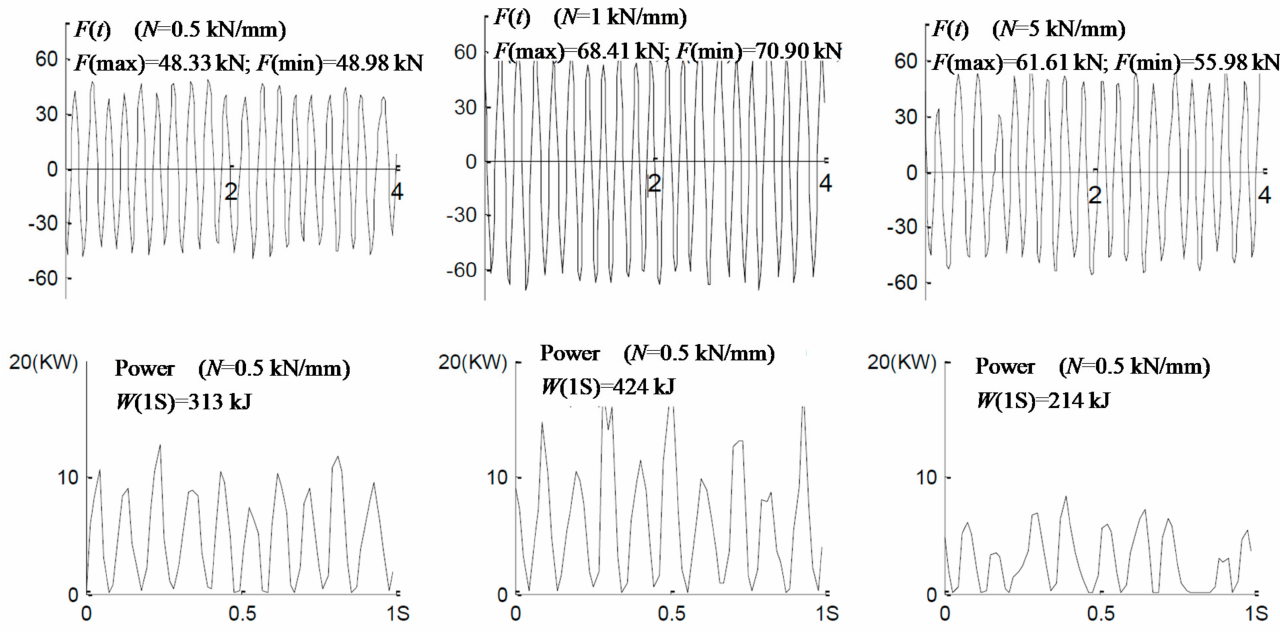
Figure 17. The time − domain diagrams of equivalent excitation force and its work power to the spring component under different elastic stiffness.